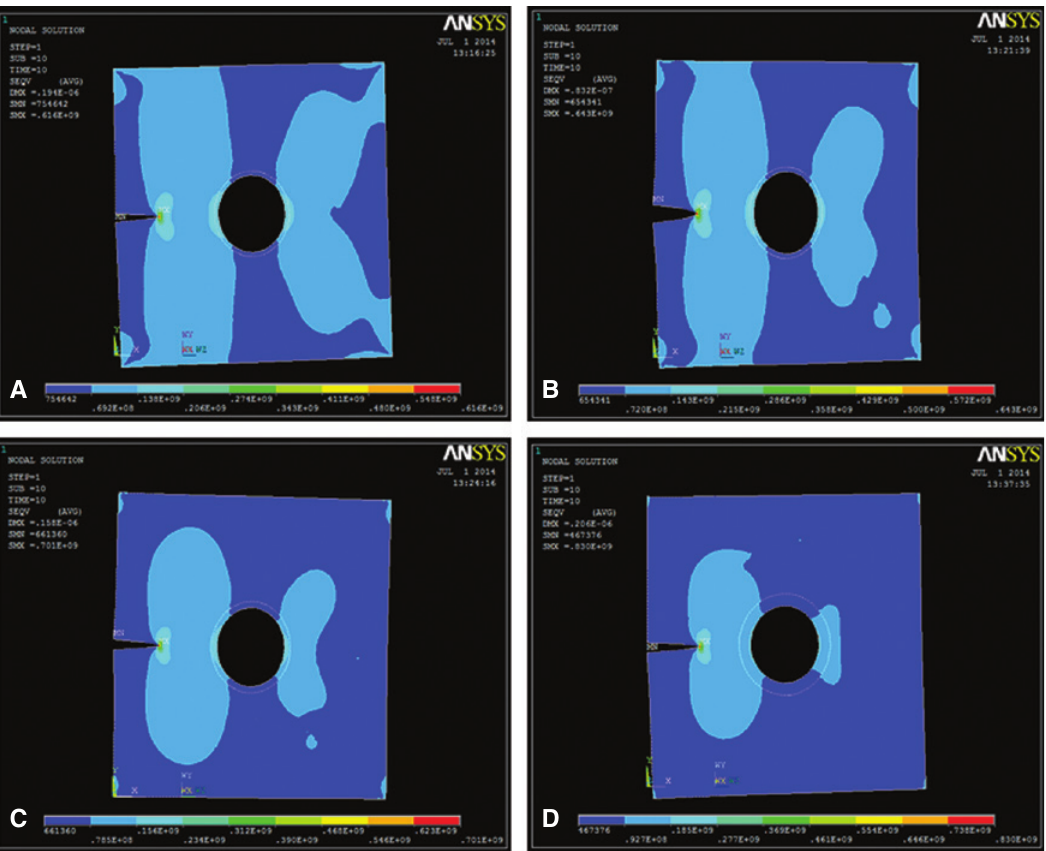
Figure 4: Stress distribution in the equatorial plane of the nanocapsule with shell thickness 78 nm (A), 110 nm (B), 138 nm (C), 183 nm